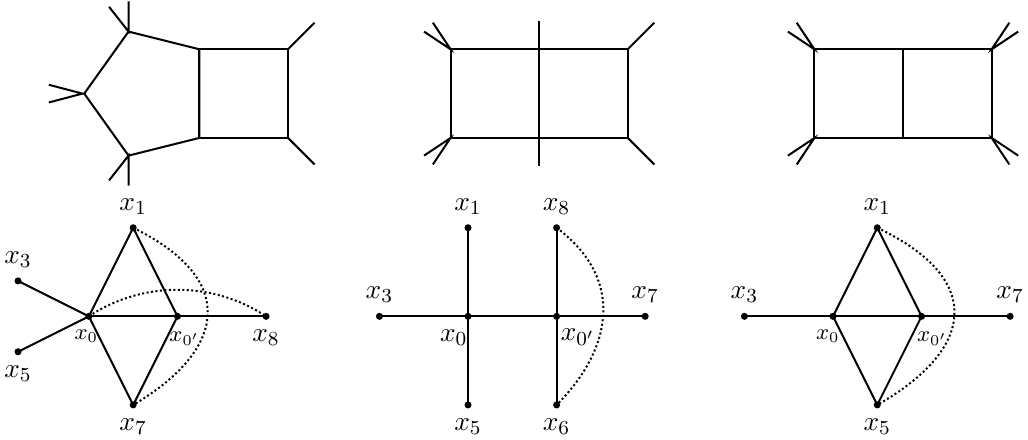
and x , represents a b